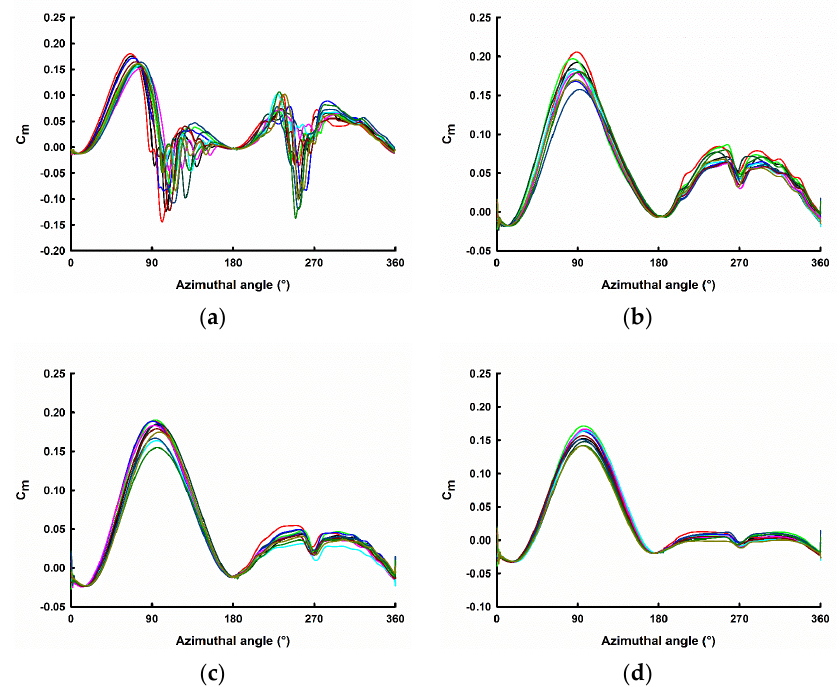
Figure 13. Coefficient of Moment (C m ) for various rotational cycles. ( a ) λ = 2.5; ( b ) λ = 3.3; ( c ) λ = 4.1; ( d ) λ = 5.3. Coefficient of Moment at various time instances (rotational cycles) are represented through different coloured lines. Due to randomized wind conditions, values vary every rotational cycle.